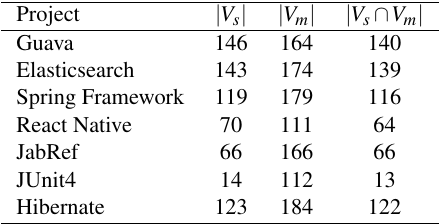
Table 3. Number of elements in V s , V m and V s ∩ V m .